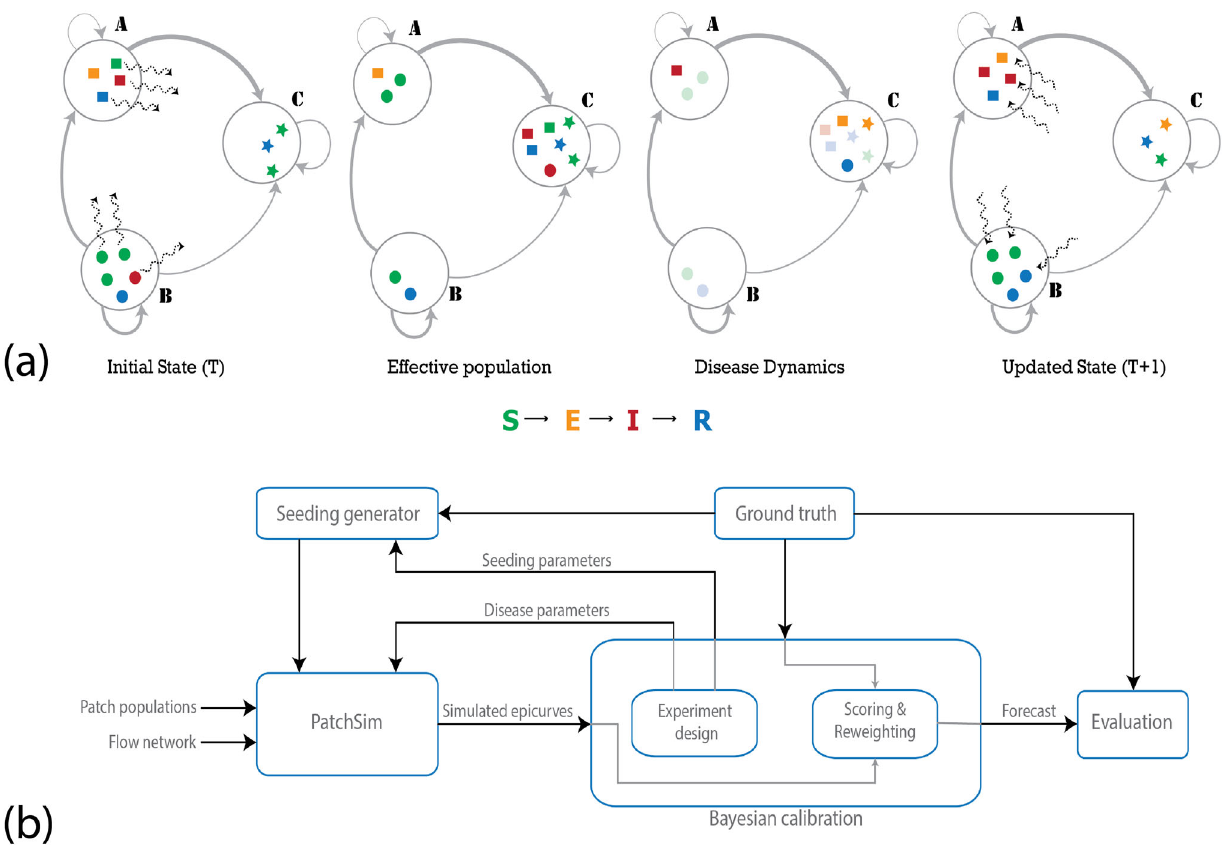
Fig. 2 Overall methodology. a Stages in a single iteration of the metapopulation model: the large circles represent the patches in the simulation, and the gray edges represent the travel network, with varying thickness denoting heterogeneity in fl ow volumes. The sample population shows four individuals in patch A (squares), fi ve in patch B (circles), and three in patch C (stars). The colors represent the disease state the individuals are in (susceptible, exposed, infected, or recovered). The wavy dashed arrows show movement of individuals (randomly chosen according to outgoing edge probabilities). In the fi rst step, individuals are moved from their home patch to another patch ( fi rst panel), creating the effective population (second panel). The disease dynamics may include exposure events (transition from S – E), onset of infectiousness (E – I), and recovery events (I – R). The nodes undergoing these transitions are highlighted in the third panel, where we see an onset of infectiousness in patch A, two exposures and a recovery in patch C. Finally, the individuals return to their home patch (fourth panel). Note that, although for descriptive purposes we use individual agents above, the system is actually simulated deterministically using the mass-action principle. b Bayesian calibration framework: the calibration involves generating samples from the parameter space, evaluating the corresponding simulated epidemic curves in comparison to the ground truth. The appropriate reweighted epidemic curves are combined to provide the forecast. See Supplementary Methods for details on both the disease model and the calibration